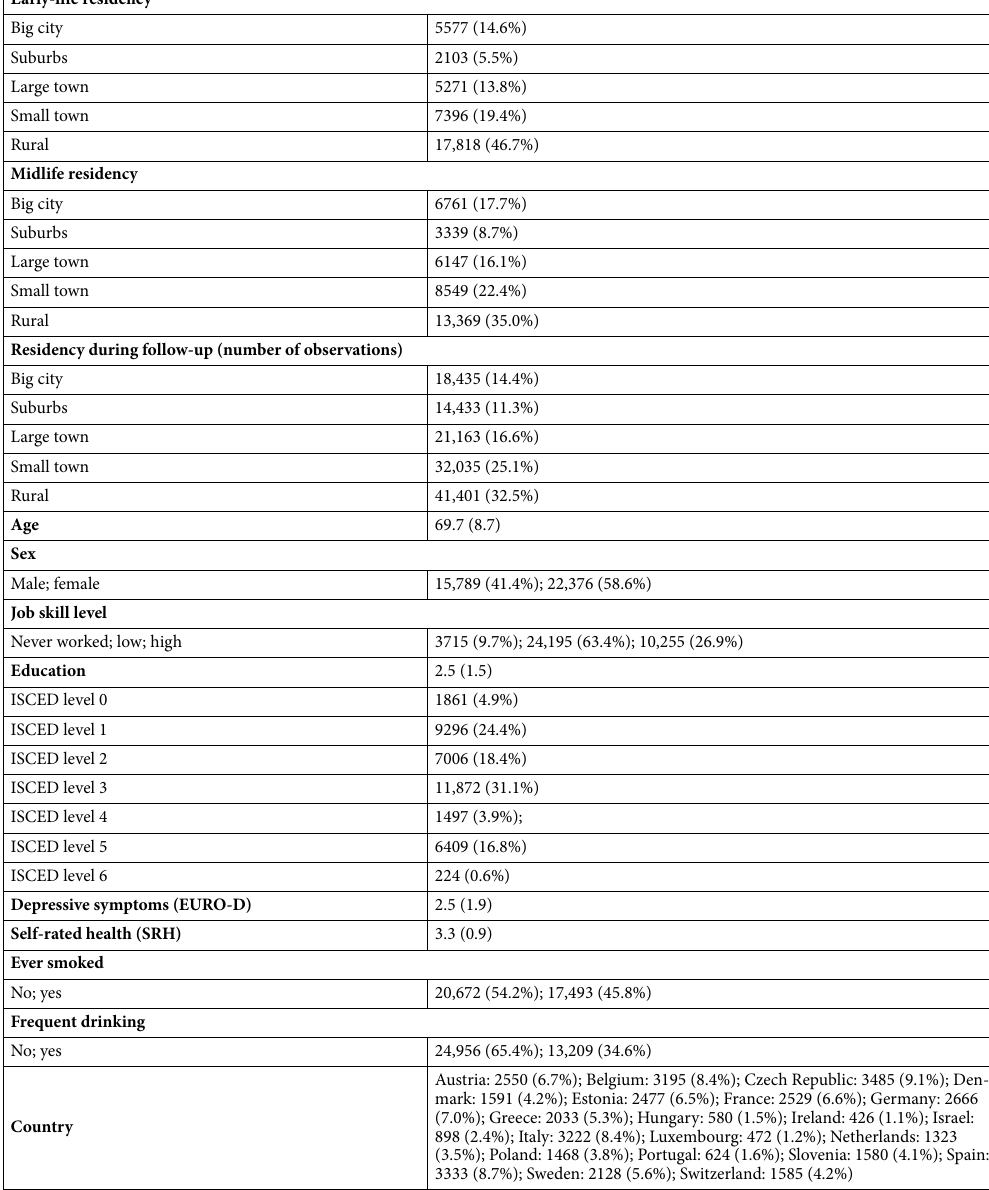
Table 4. Descriptive statistics for covariates. Means and standard deviations (in parentheses) for continuous variables, number of cases and percentages (in parentheses) for categorical variables. Descriptives for time- varying variables (residency during follow-up and age) calculated using observations from verbal fluency